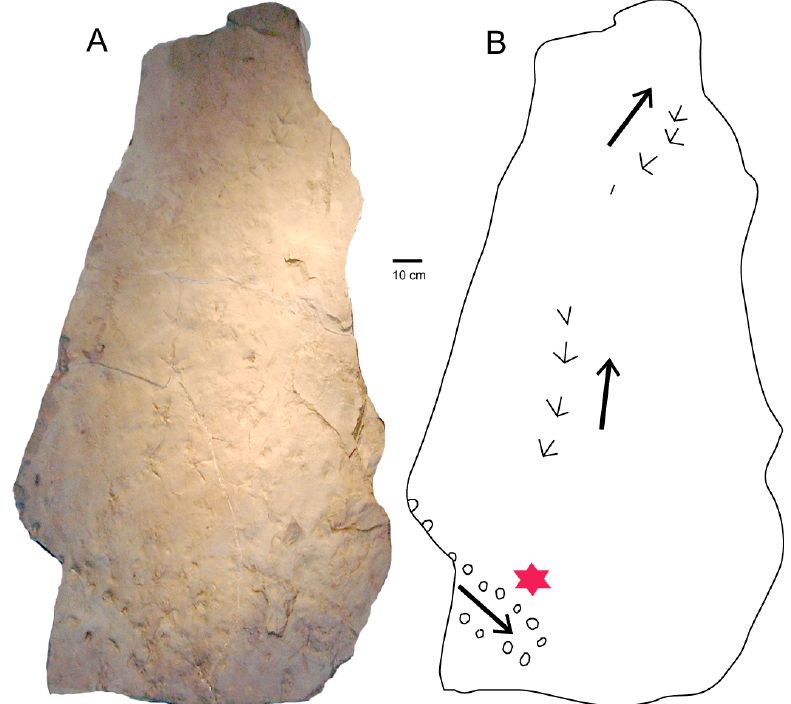
Figure 6. ( A ) Slab found in 1990 at WWU-KC-1 site preserves a turtle trackway and footprints of a heron-like bird. ( B ) Turtle trackway marked with star. Arrows show travel directions. The specimen